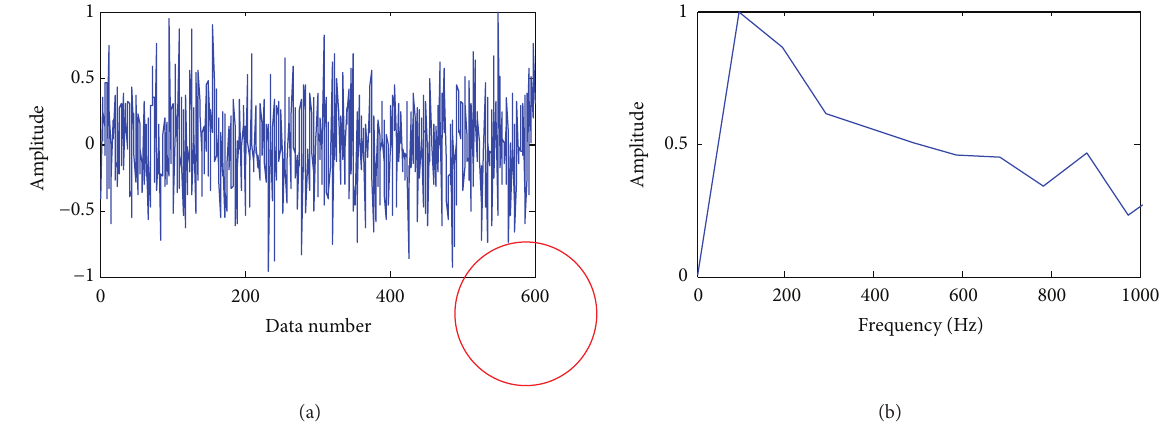
Figure 12: (a) Random sampling and (b) envelope spectrum of the original signals with 600 points.